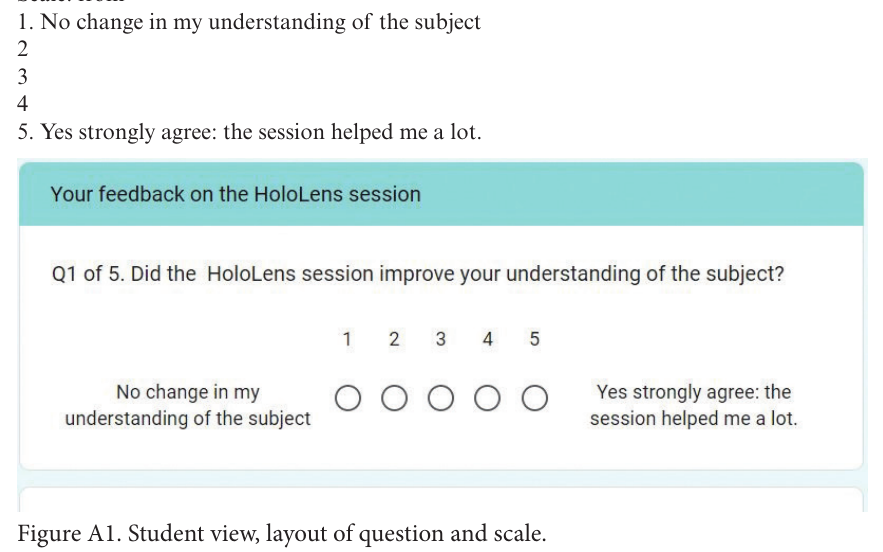
Figure A1. Student view, layout of question and